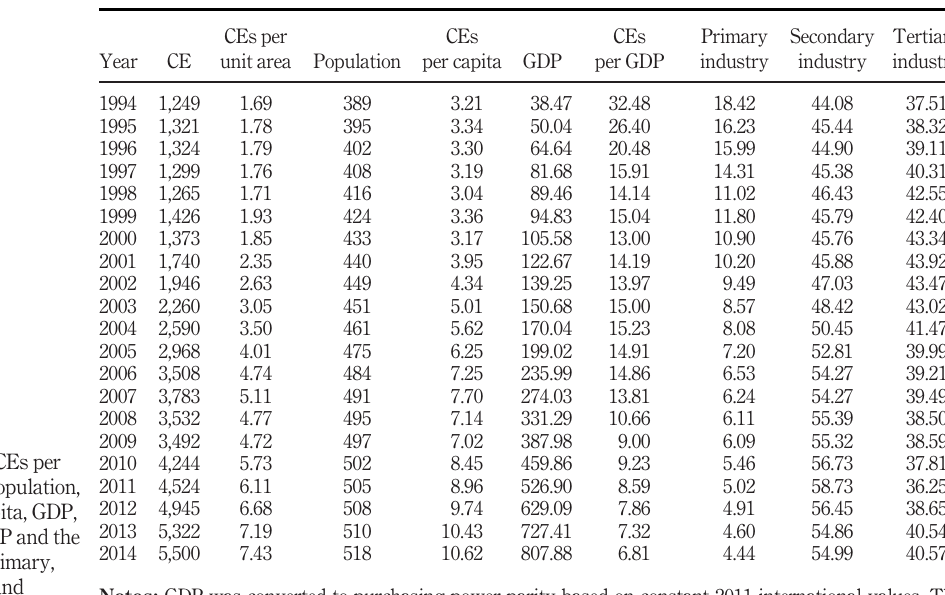
Table II. Total CEs, CEs per unit area, population, CEs per capita, GDP, CEs per GDP and the shares of primary, secondary and tertiary industries